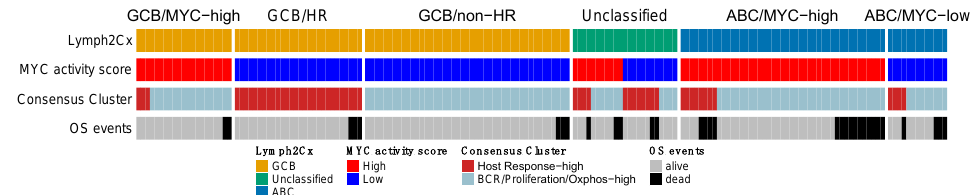
Figure 4. Overlap of the gene expression signatures that were validated in the HOVON-84 cohort. The three signatures show no clear overlap and together are likely to capture different aspects of DLBCL biology. OS events were observed in each of the six clusters, with a slight enrichment in the ABC/MYC-high group.